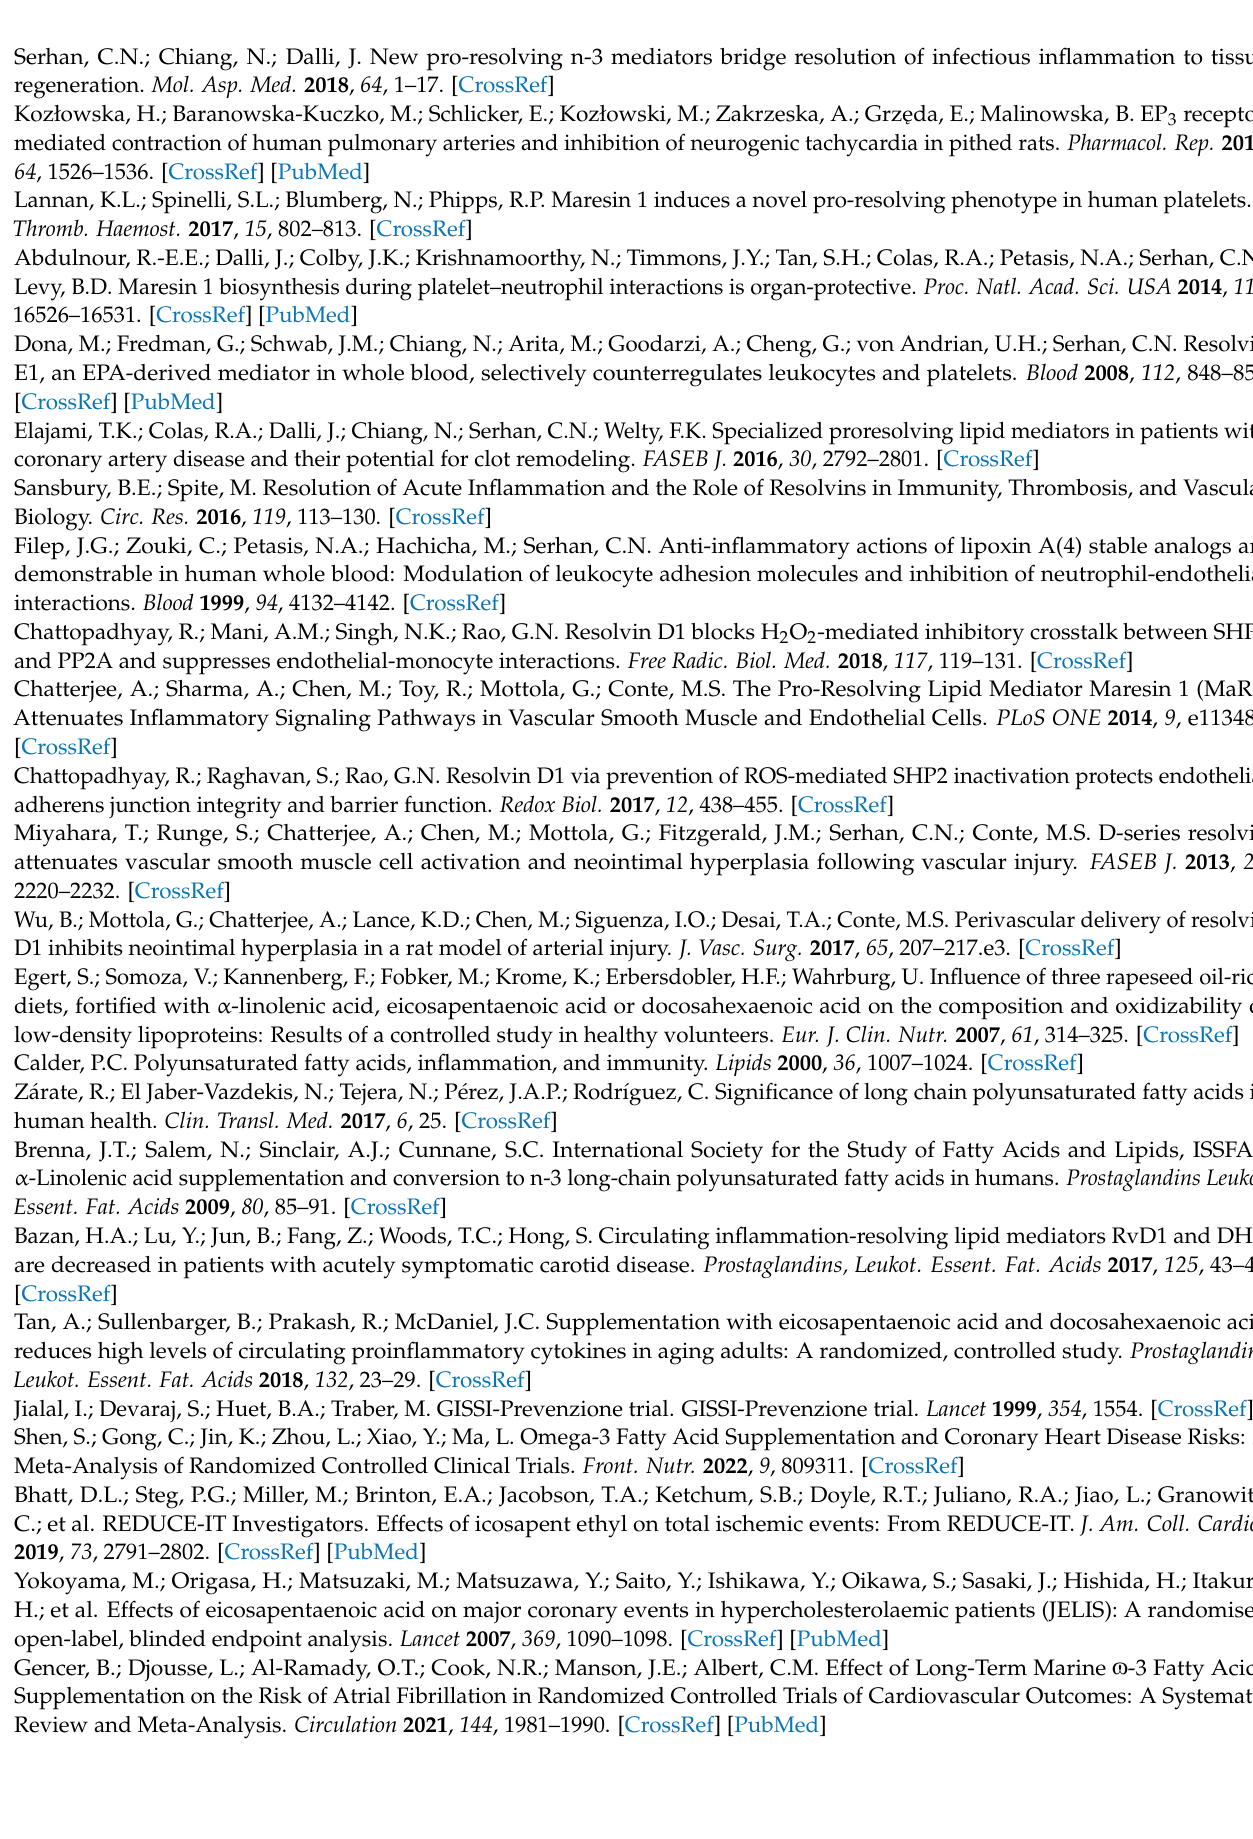
Table 3 . Trials on ω -3 fatty acid diet in